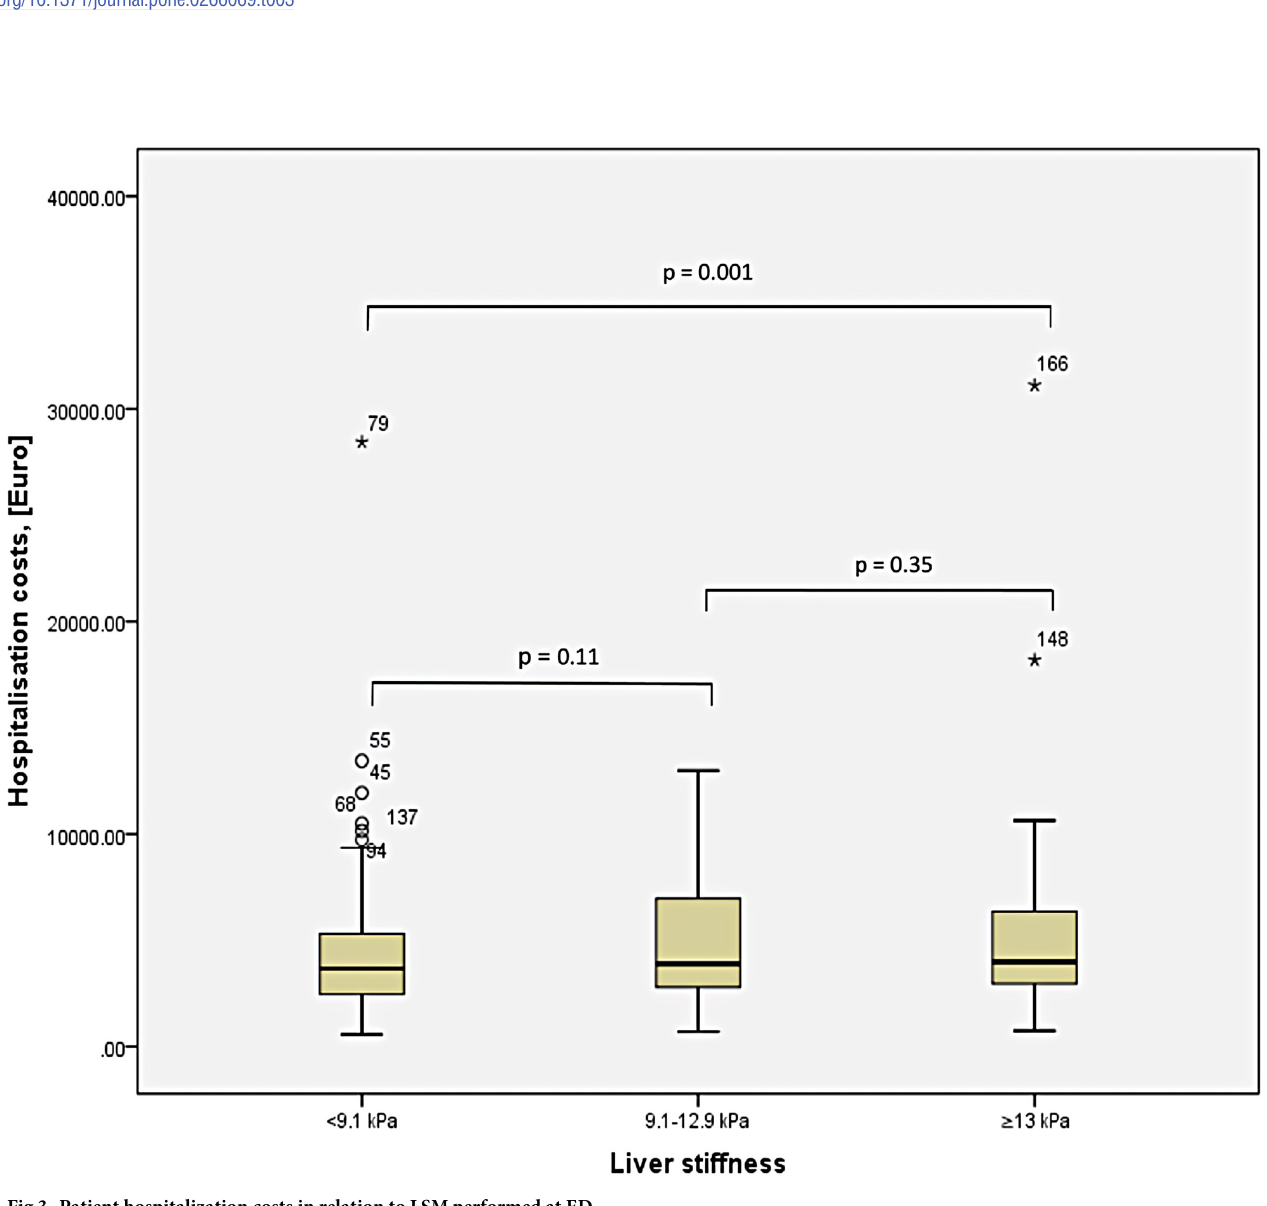
Fig 3. Patient hospitalization costs in relation to LSM performed at